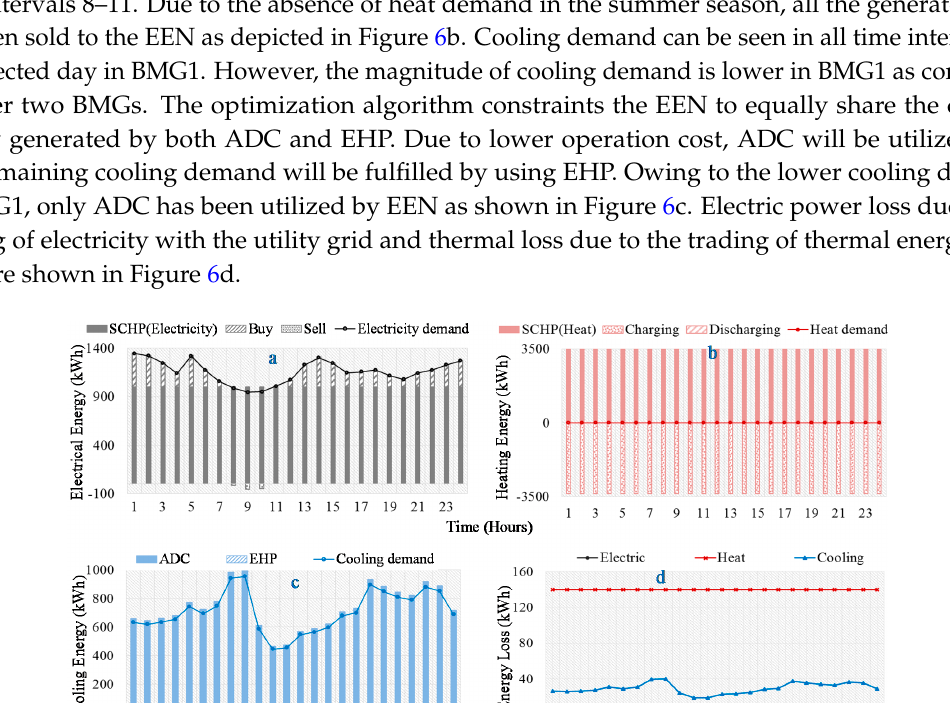
Table 2. Season-wise heat trading prices of BMGs and heat to power ratios of CHPs.